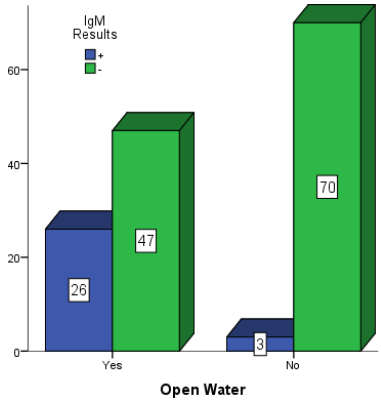
Figure 5. Participants with open water in their surroundings in Mubi